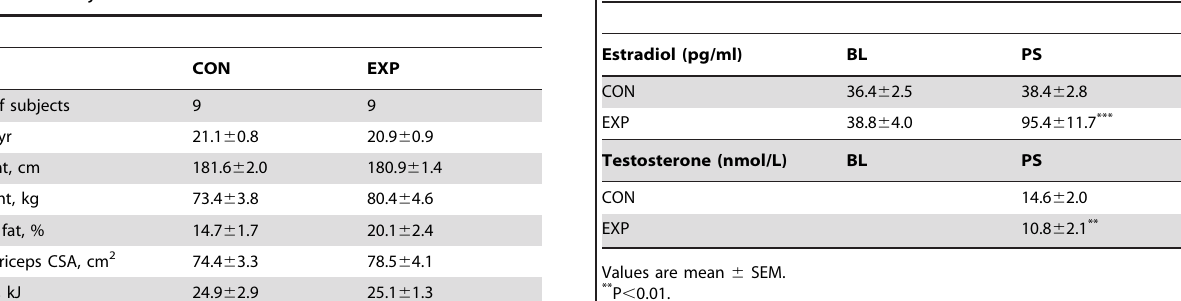
Table 3. Serum hormone concentrations after 8d of supplementation with either placebo (CON) or E2